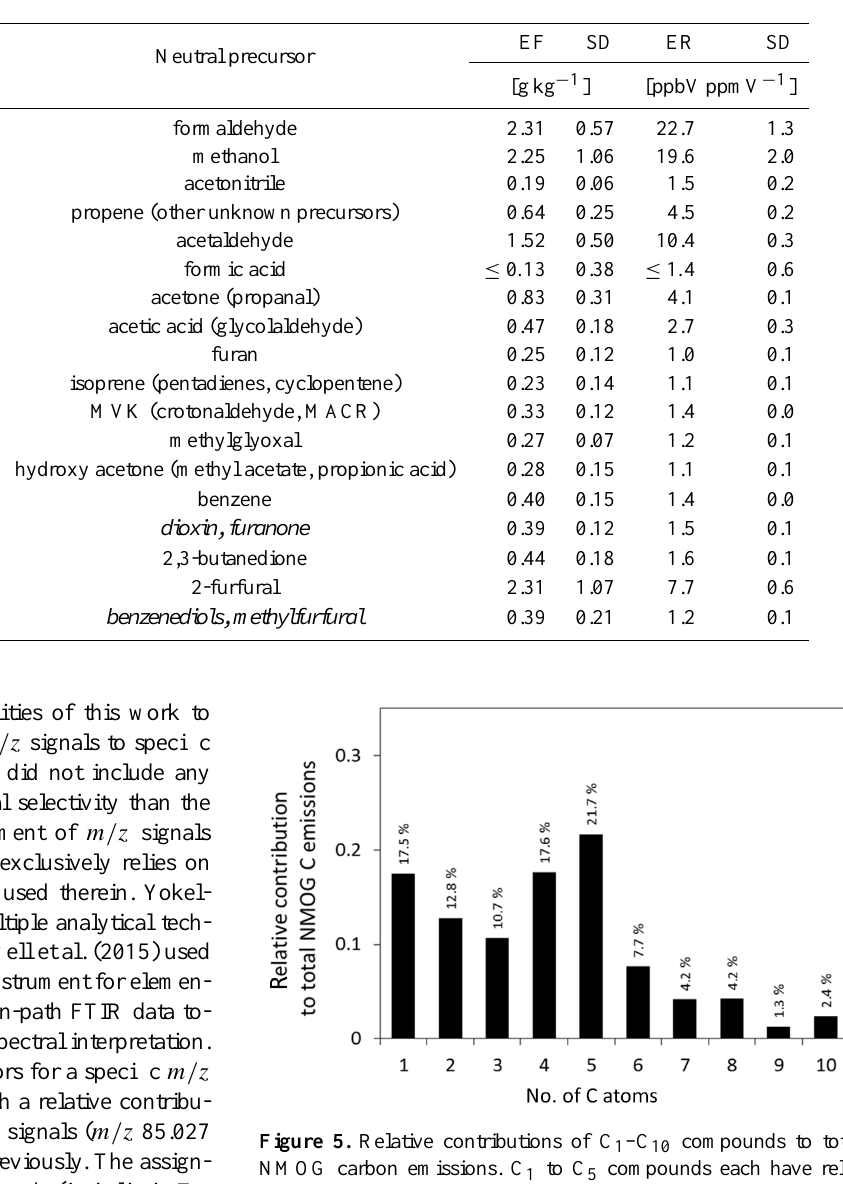
emissions (ER X / CO > 50 pptV ppmV − 1 ) were detected only up to C 10